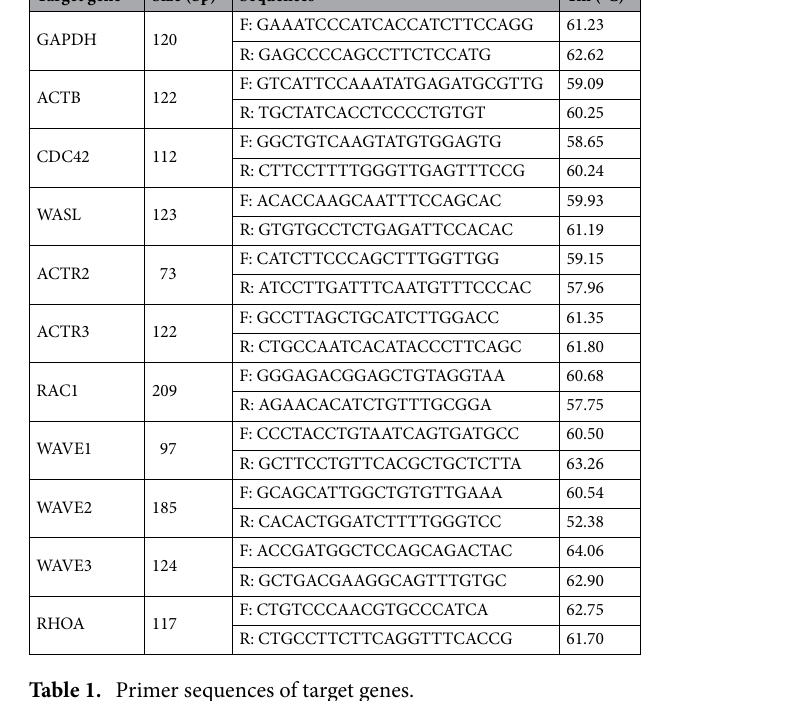
Table 1. Primer sequences of target